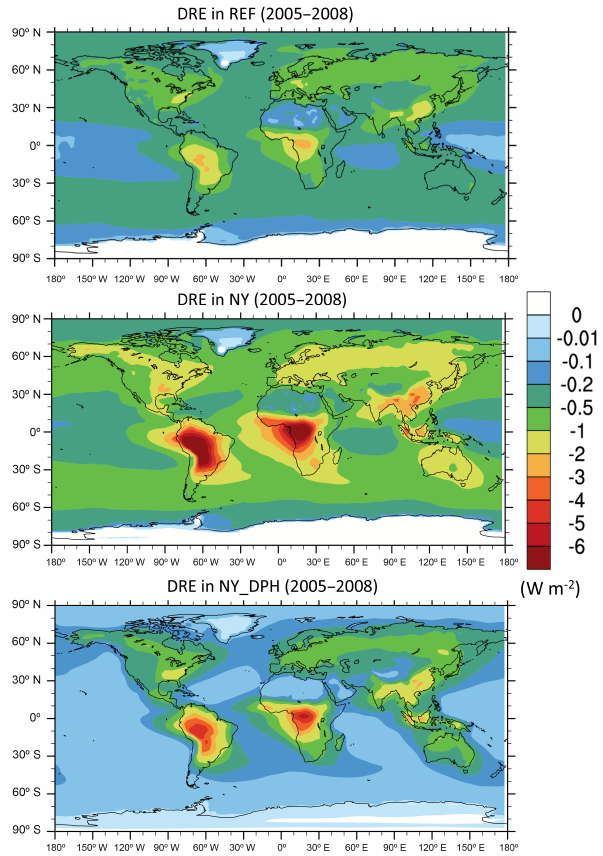
Figure 11. Simulated clear-sky SOA direct radiative effect (DRE) at the top of the atmosphere for the REF (upper), NY (middle) and NY_DPH runs